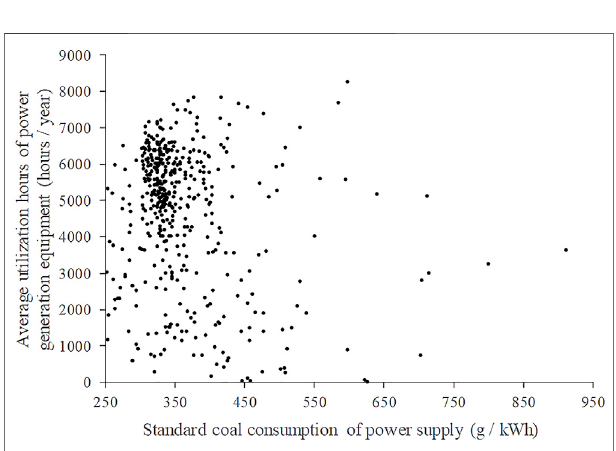
FIGURE 2 | Standard coal consumption and annual average utilization hours for Chinese power plants of 6,000 kW and above in